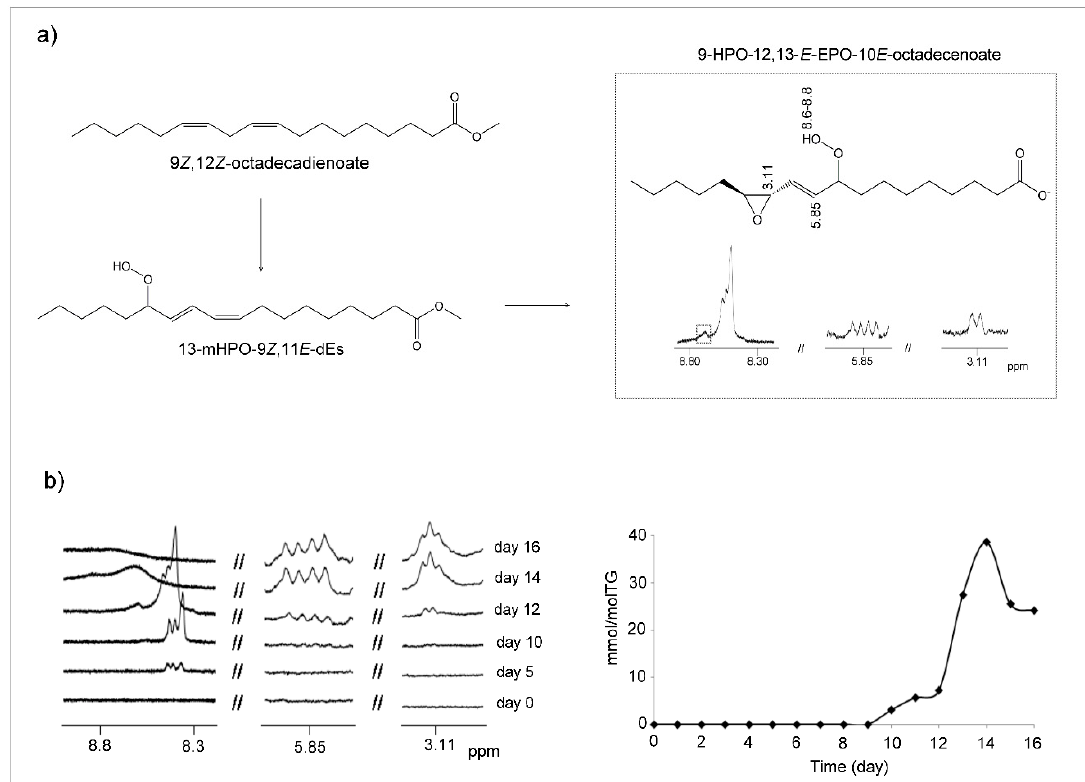
Figure 4. ( a ) Pathway of formation of hydroperoxy-epoxy-monoenes (HPO-EPO-mEs) proposed by some authors under certain oxidation conditions [56], together with some chemical shifts (ppm) of the 1 H NMR signals of some of their hydrogen atoms. ( b ) Enlargements of some spectral regions where changes occur throughout the accelerated storage process and their evolution with time, together with the graphical representation of the evolution of the concentration of 9-HPO-12,13- E -EPO-10 E -octadecenoate, expressed as mmol / mol TG, present in corn oil submitted to accelerate storage conditions, versus time given in days.